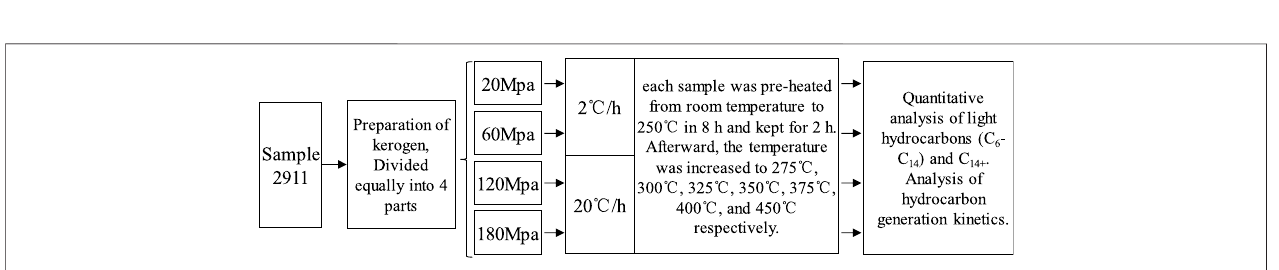
FIGURE 2 | Schematic diagram of the pyrolysis